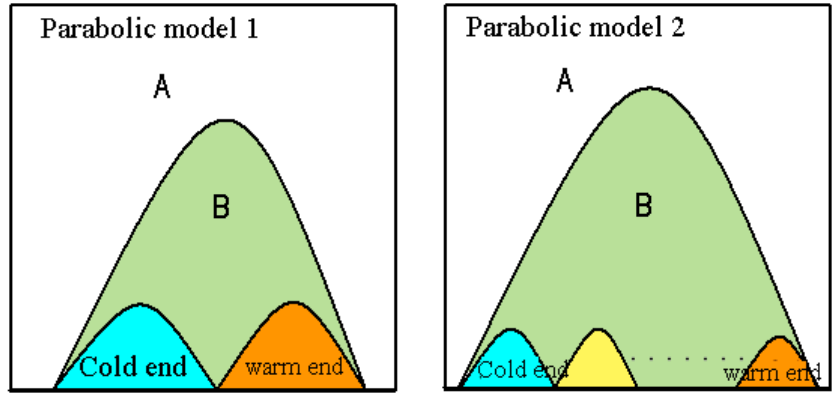
Figure 2. Parabolic model of a block.